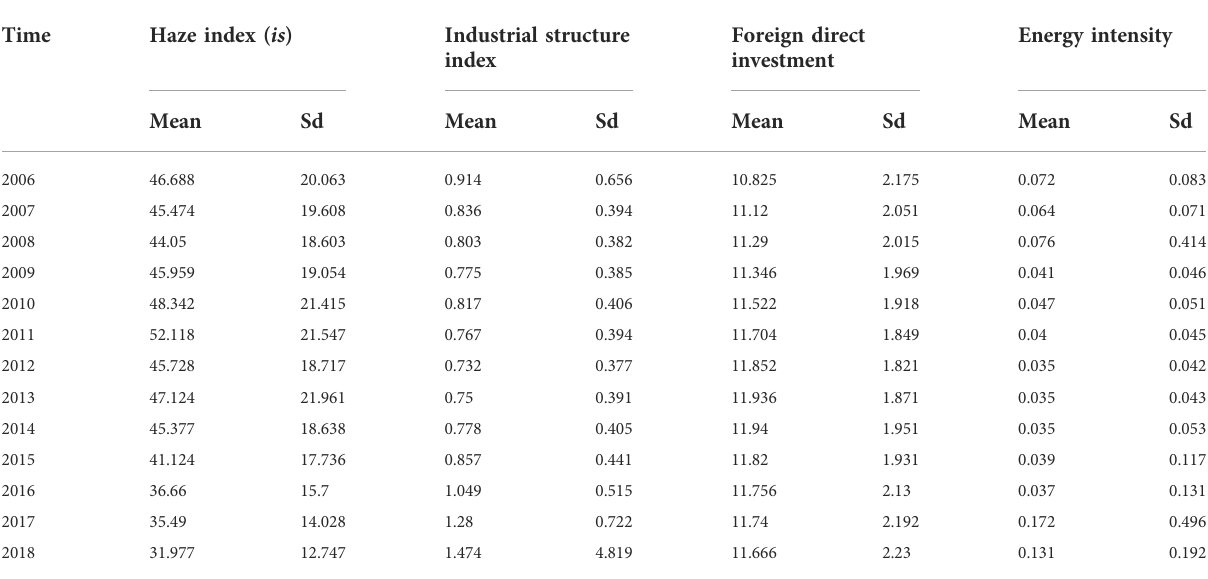
TABLE 1 Description of data.